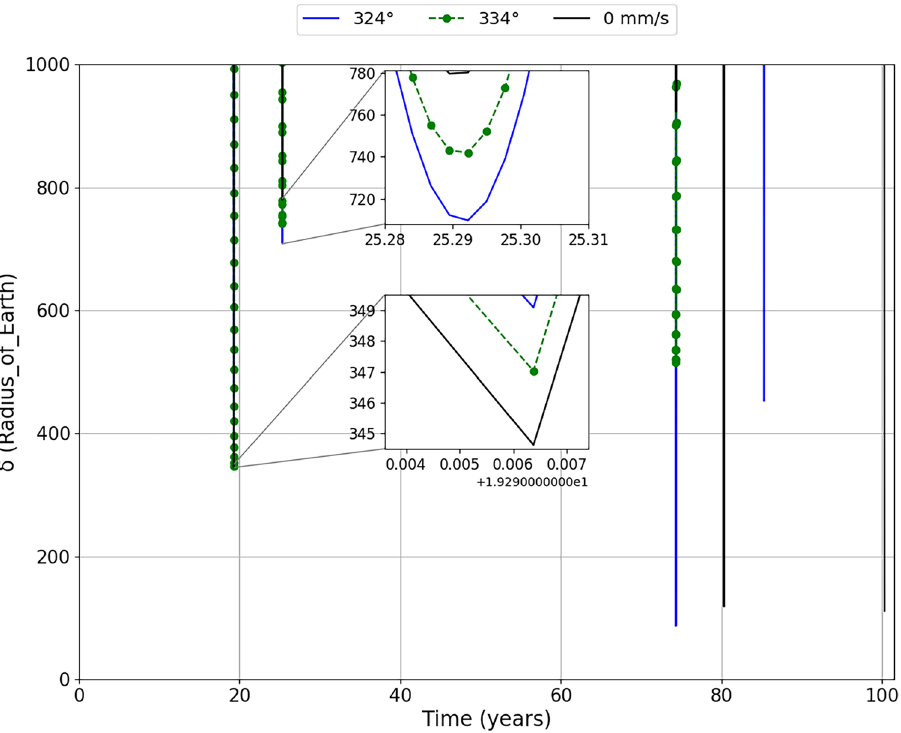
Figure 6. The relative distances between the asteroid and the Earth ( δ ) when the impulse of −20 mm/s is applied at the mean anomalies of 324° (blue line) and 334° (green dashed line), in June 17, 1980 and June 5, 1980, respectively. We zoomed in on the first two close encounters to better visualize the variations in the approach between the asteroid and the